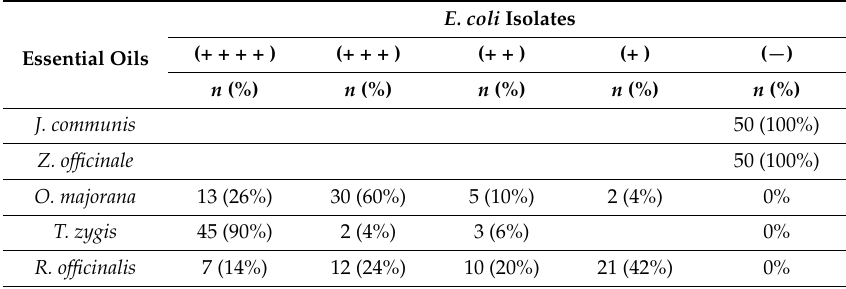
Table 2. Antibacterial activity of essential oils against E. coli isolates using disc diffusion.